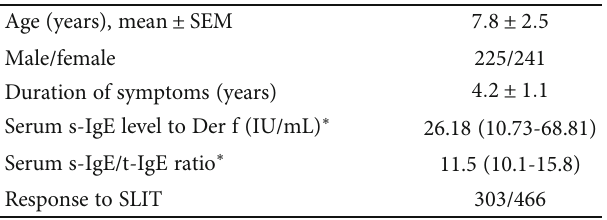
Table 1: Baseline characteristics of 466 patients that underwent SLIT.